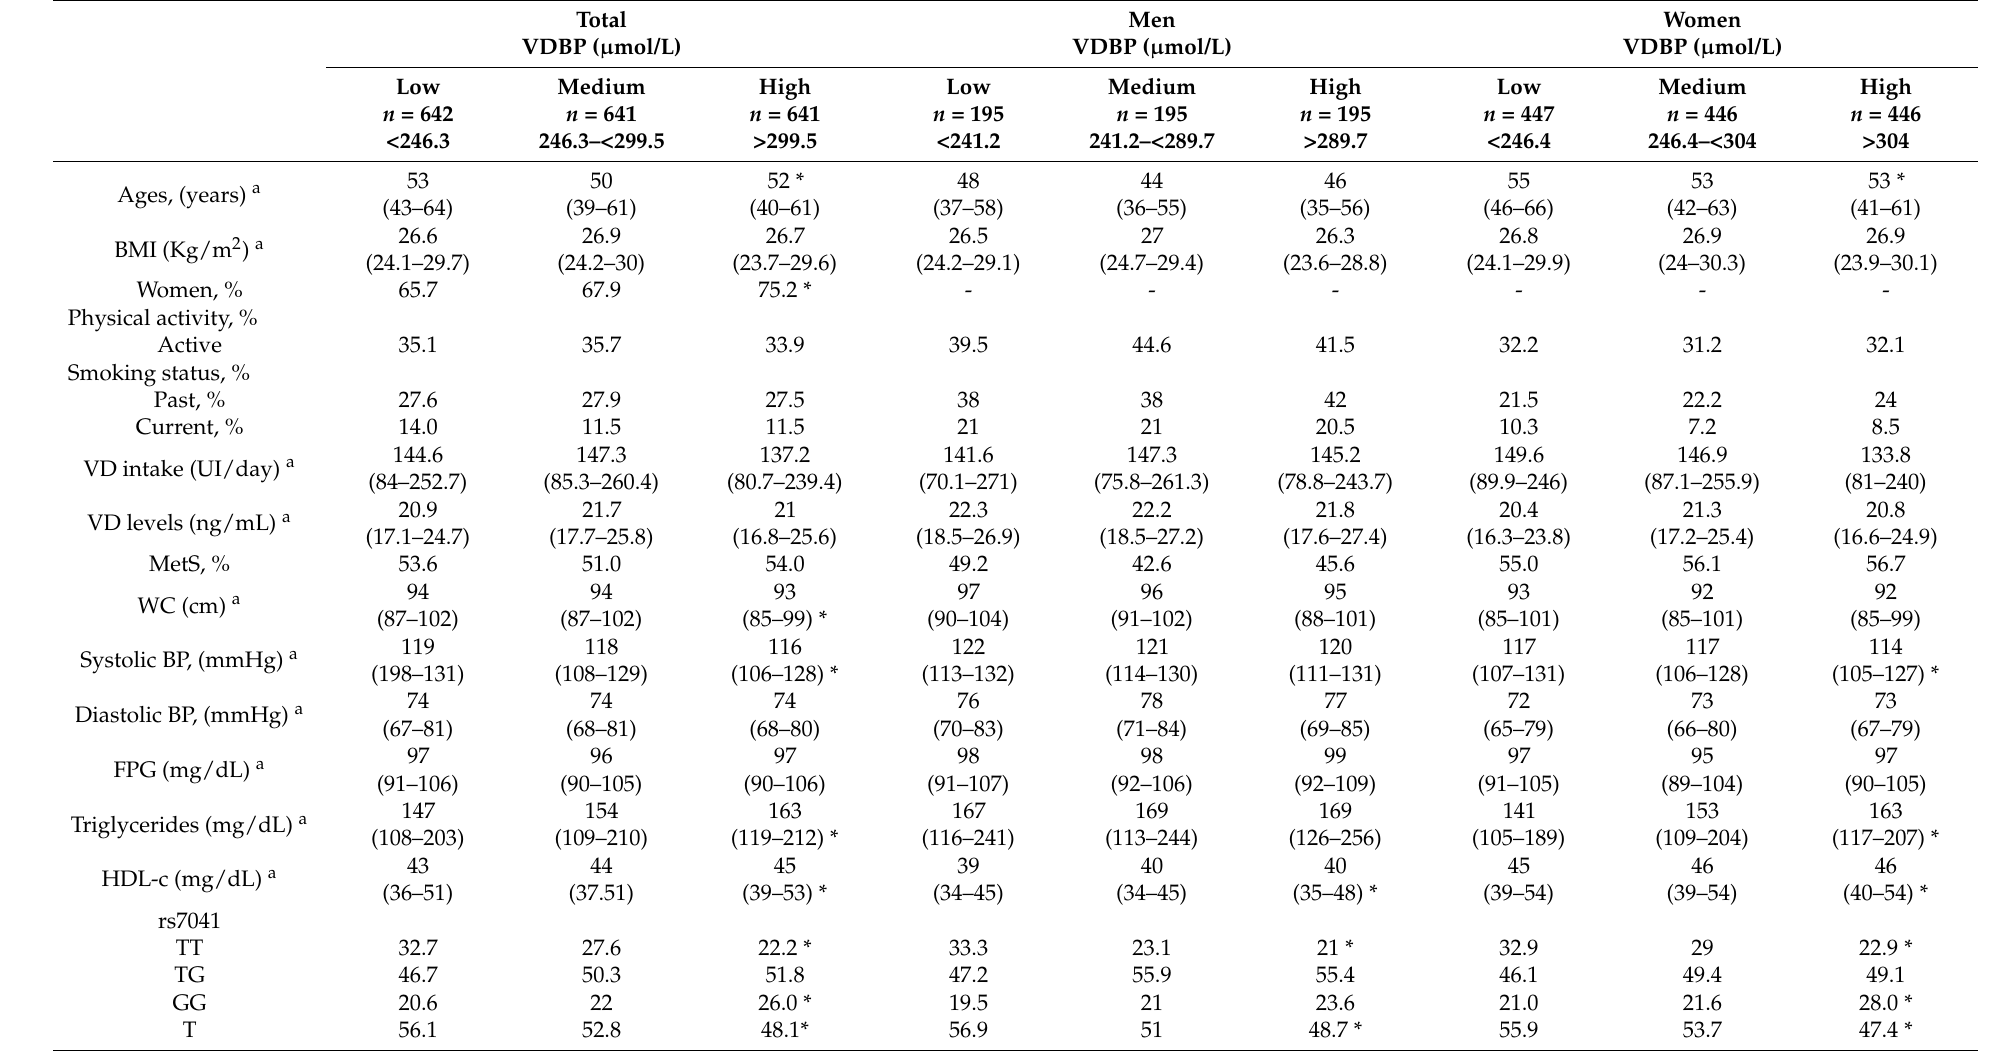
Table 3. Distribution of sociodemographic characteristics and lifestyle factors according to VDBP categories defined by